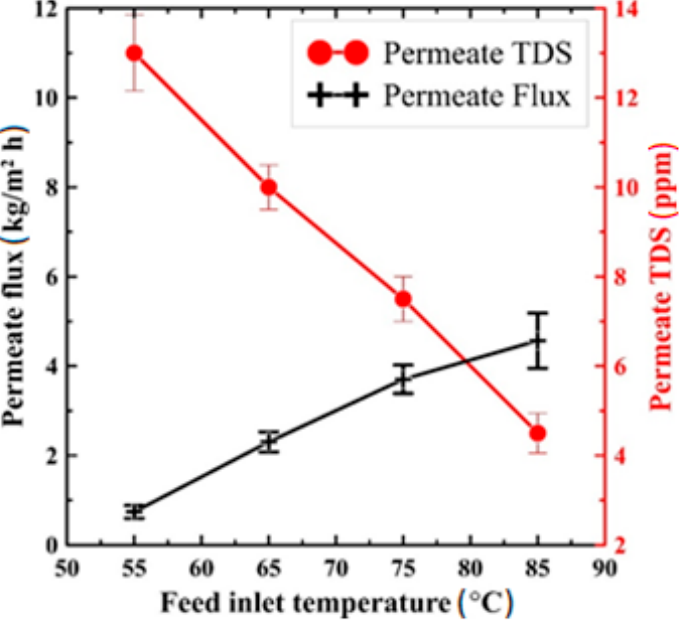
Figure 8. Effect of feed inlet temperature on permeate flux and TDS of the produced water at 100 mL/min flow rate and 10,000 ppm feed salt concentration.